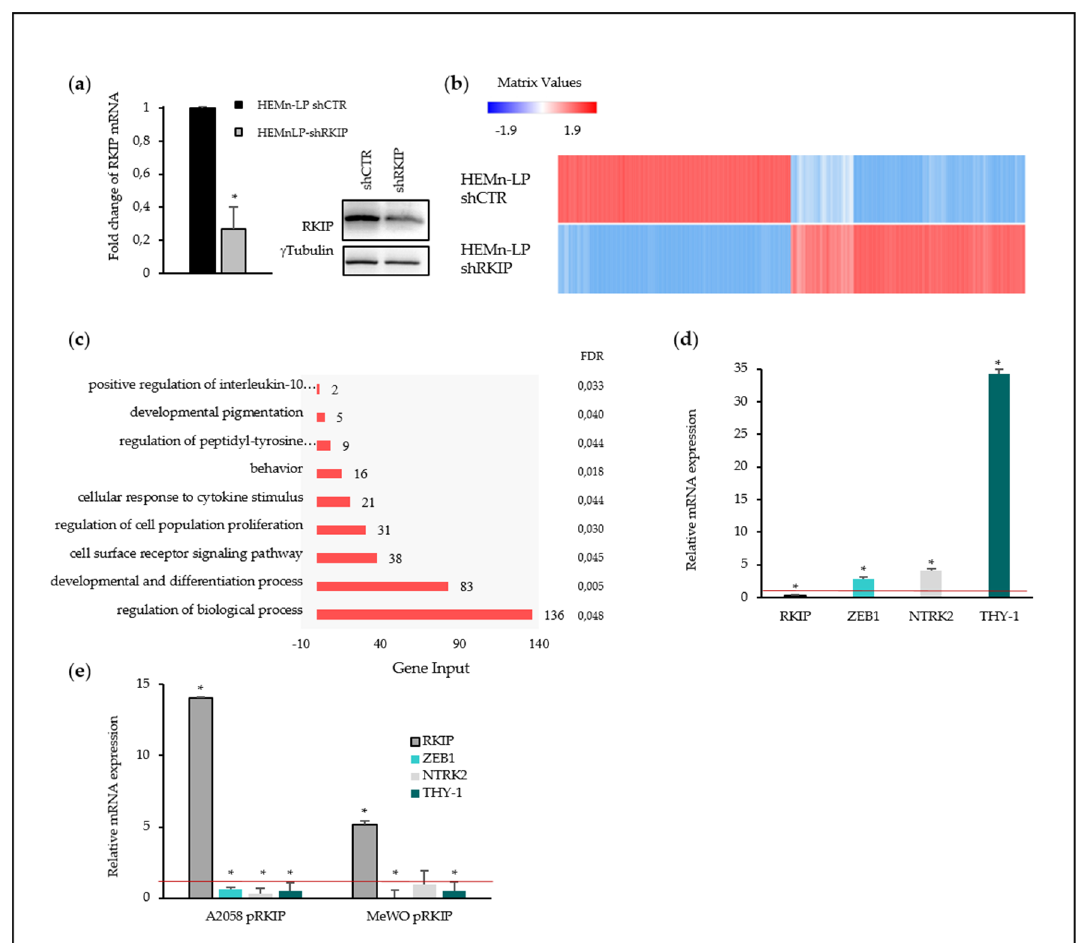
Figure 5. RNA Sequencing data and analysis. ( a ) RKIP mRNA and protein levels in RKIP-downregulated HEMn-LP. Normal melanocyte cell line HeMn-LP was transduced with RKIP shRNA Lentiviral Particles or Control shRNA Lentiviral Particles following the manufacturer´s instruction. Two days after infection, the cells were selected with Puromycin to get stable cell lines. The RKIP downregulation were validated by RT-qPCR and Western Blot; ( b ) Clustergram analysis showing di ff erential expression genes data set comparing controls versus RKIP knockdown HEMn-LP cells; ( c ) Every row of the figure represents one enriched process after RKIP downregulation with an FDR cuto ff of 0.05; ( d ) Relative expression of three selected genes for RNASeq results validation in shRKIP HEMn-LP; ( e ) Relative expression of three selected genes for RNASeq results validation in metastatic melanoma cells after RKIP upregulation. ( d , e ) ACTB was used as a housekeeping gene for relative quantification. The average of three independent assays have been shown. The red line highlights the control normalized expression level. * p -value < 0.05.